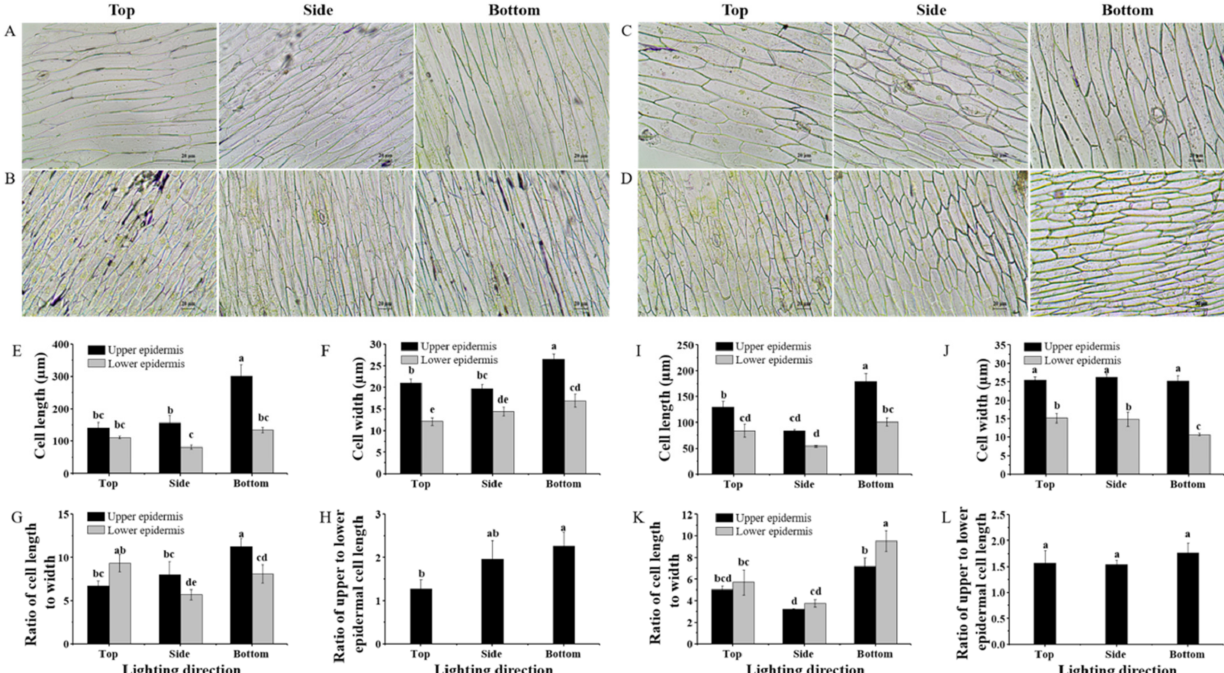
Figure 2. Upper and lower epidermal cell morphology of lettuce Caesar Green ( A , B ) and Polla ( C , D ), cell length and width, ratio of cell length to width, and ratio of the upper and lower epidermal cell lengths of lettuce Caesar Green ( E – H ) and Polla ( I – L ) as affected by the lighting direction. Vertical bars indicate the means ± stand error ( n = 3). Different small letters indicate the significant separation within treatments by the Duncan’s multiple range test at p ≤ 0.05. Bars indicate 20 µ